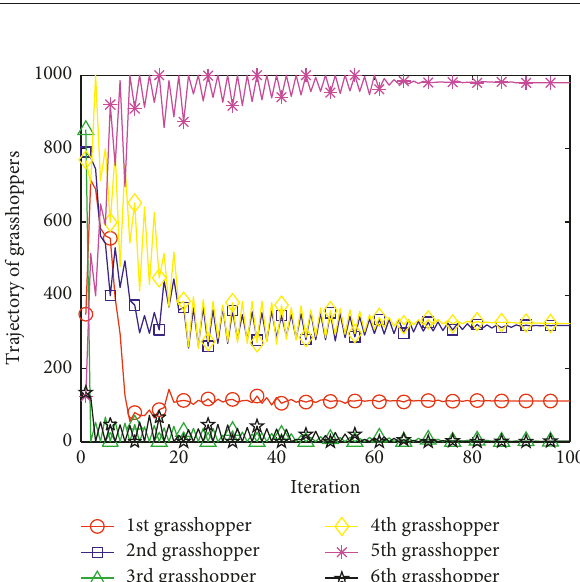
Figure 15: The trajectory behavior of 6 grasshoppers.